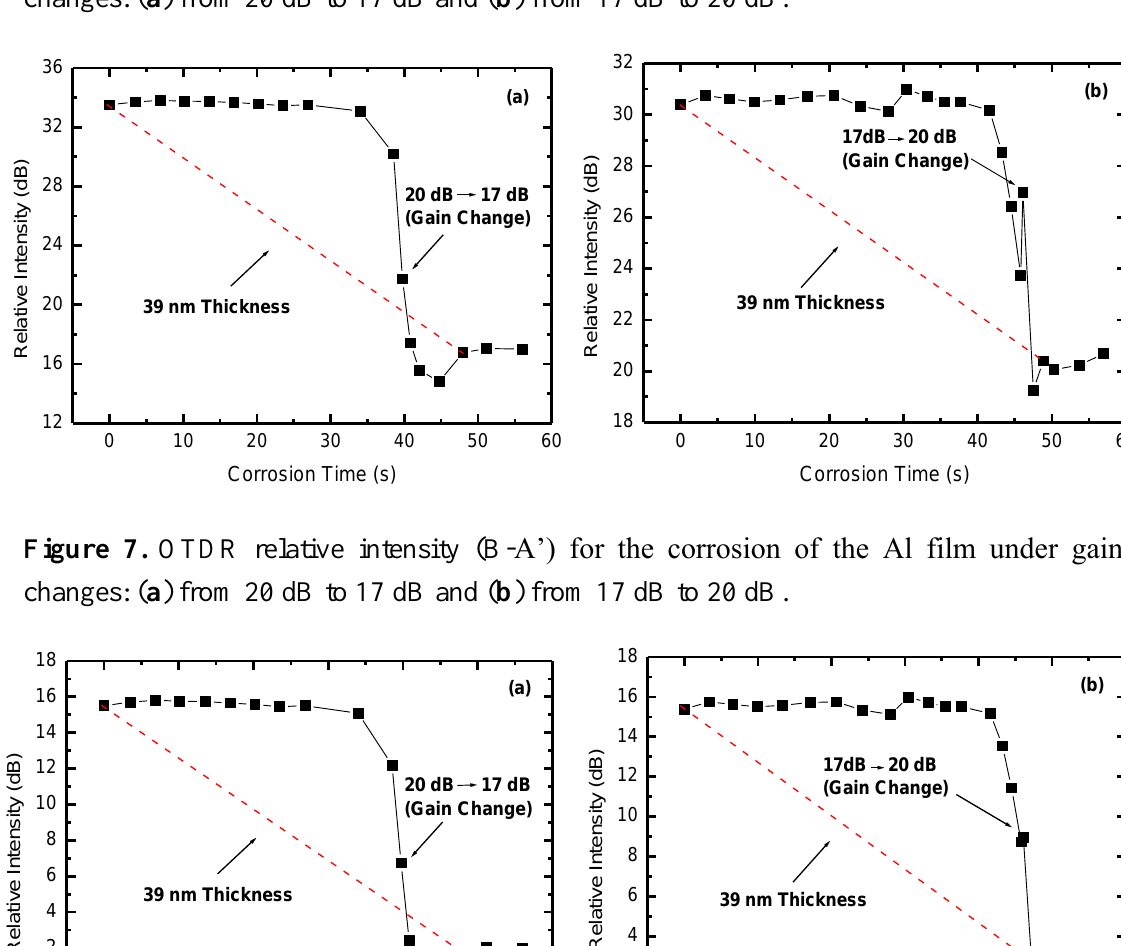
changes: ( a ) from 20 dB to 17 dB and ( b ) from 17 dB to 20 dB.